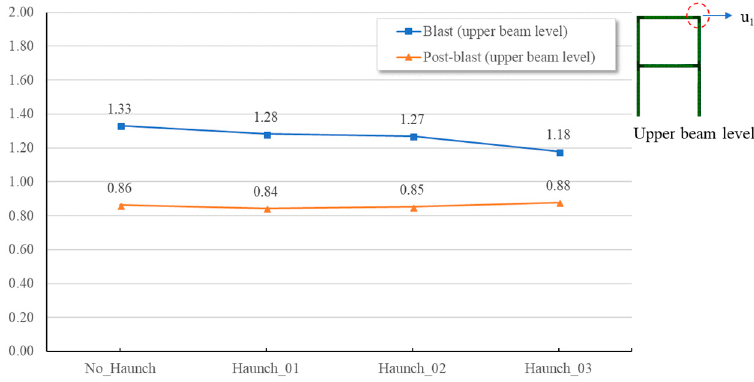
Figure 24. Frames Figure 24. Frames ductility. Figure 24. Frames ductility.